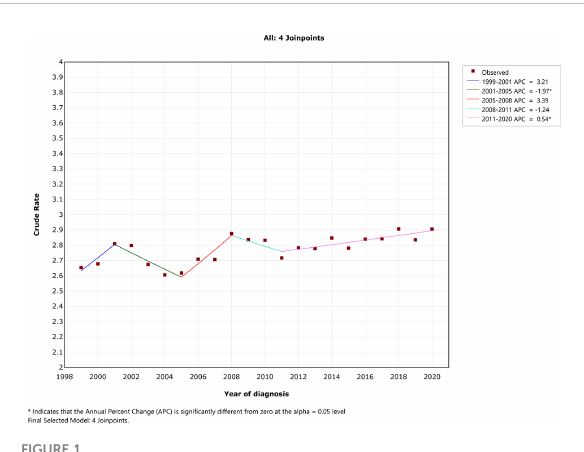
FIGURE 1 Trends of early-onset colorectal cancer death in the US population.